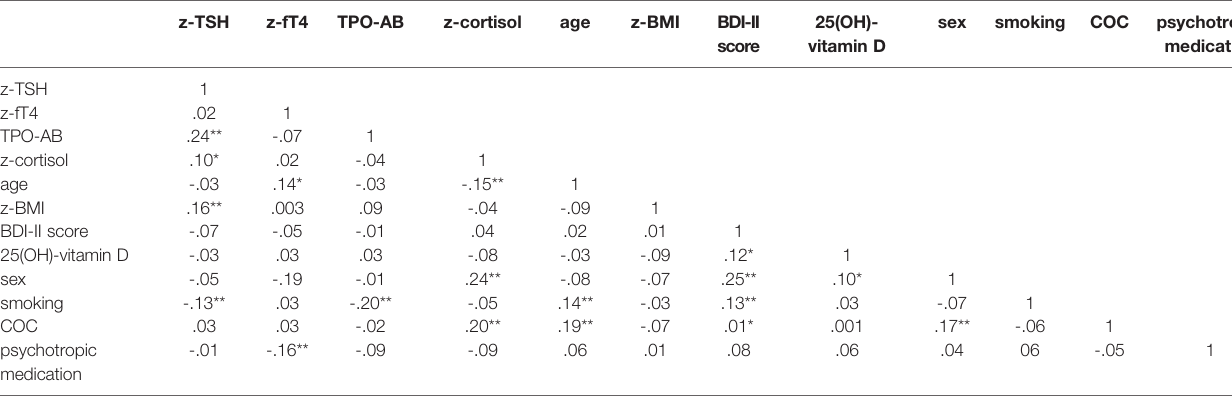
TABLE 2 | Bivariate